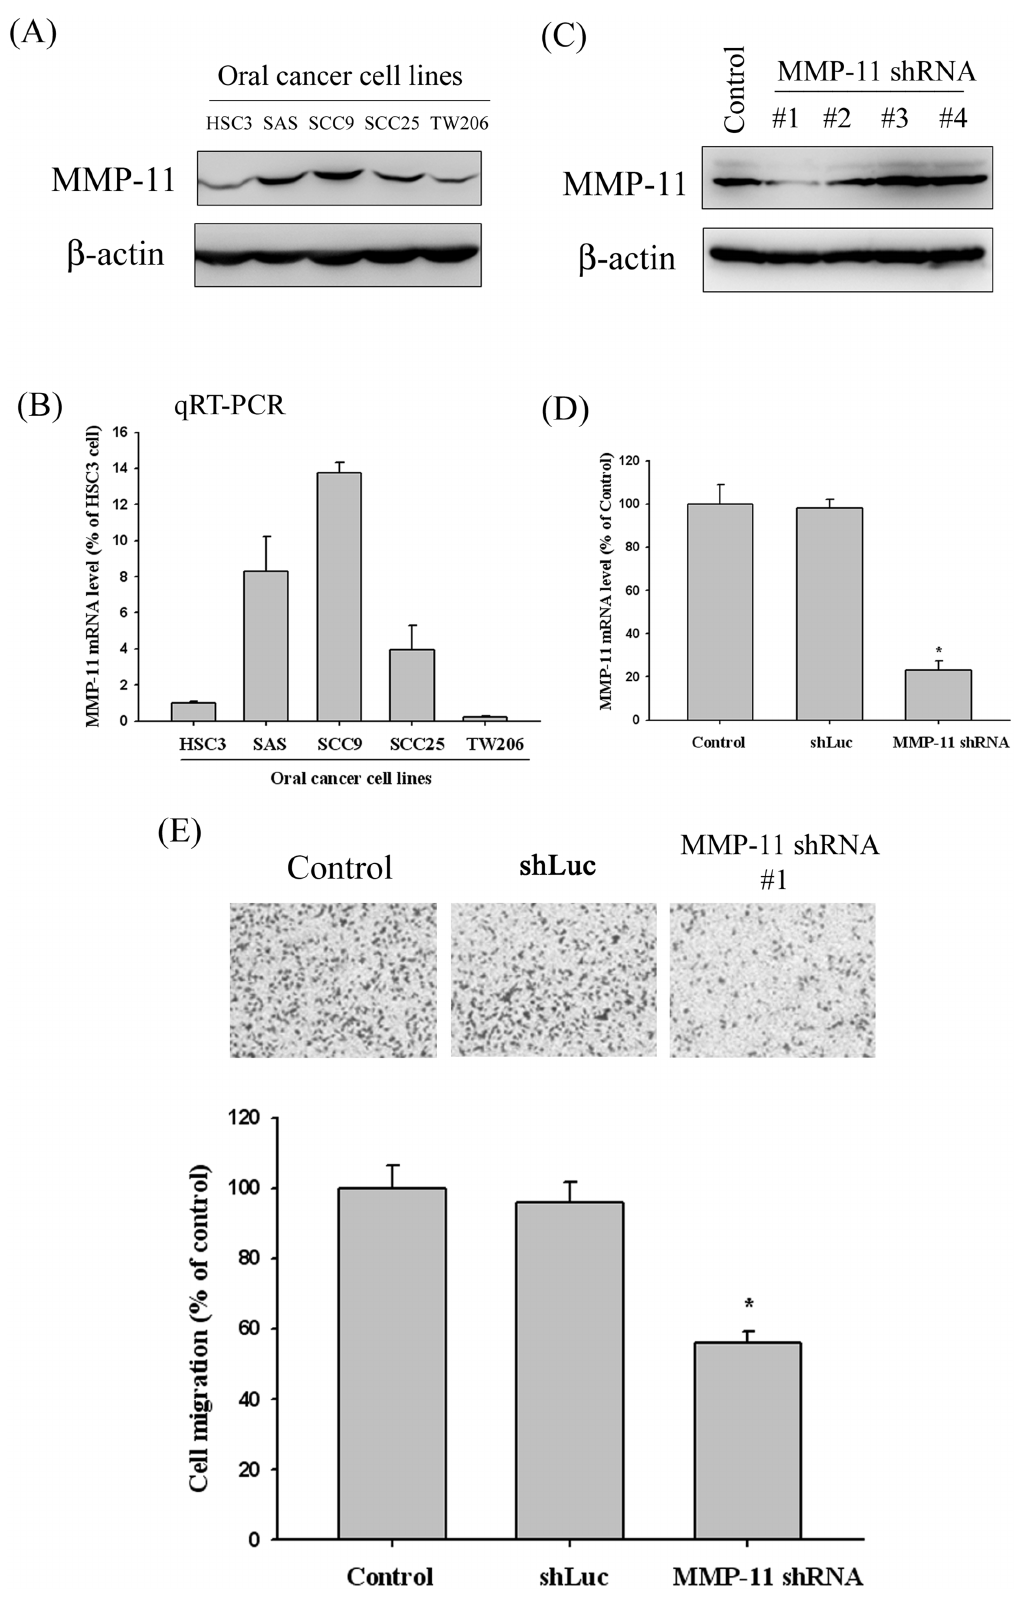
Figure 2. MMP-11 expression in oral cancer cell lines and the MMP-11 knockdown in SCC9 cells reduce cell migration. (A) Western blot analysis showing the expression of MMP-11 protein in five oral cancer cell lines. (B) MMP-11 mRNA levels in five oral cancer cell lines were determined by quantitative real-time PCR using b -actin as an endogenous control. Results are shown as mean 6 SD of three independent